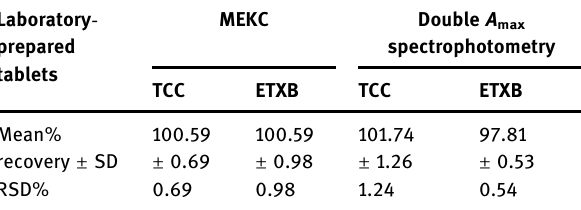
Table 3: Assay of TCC and ETXB in their combined tablets using